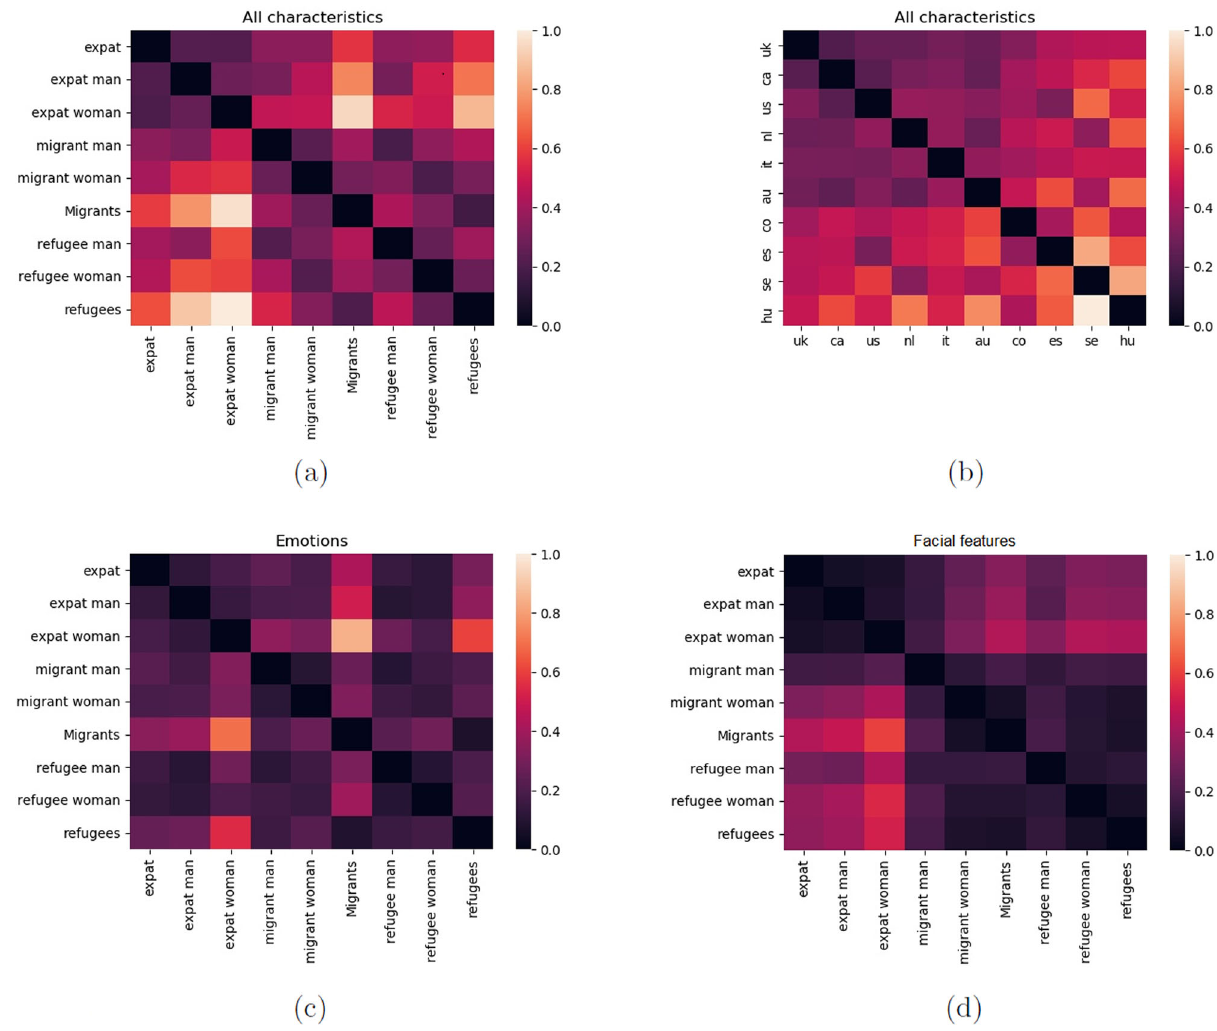
Fig. 4 Average KL divergences across demographic characteristics and emotions. On the top: divergences across demographic characteristics between a groups and b locations. On the bottom: divergences across groups for c emotions and d facial features. Lighter colors mean higher divergence. HUMANITIES AND SOCIAL SCIENCES COMMUNICATIONS| (2022) 9:410